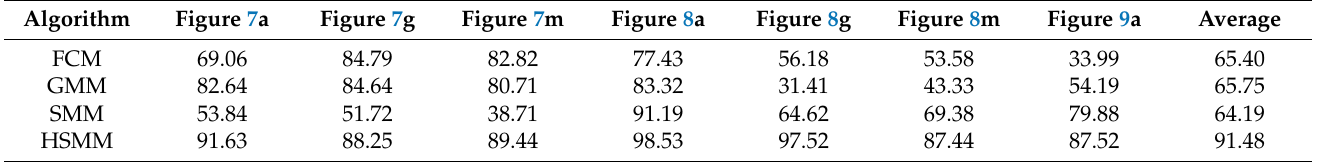
Table 4. The segmentation accuracy of remote sensing